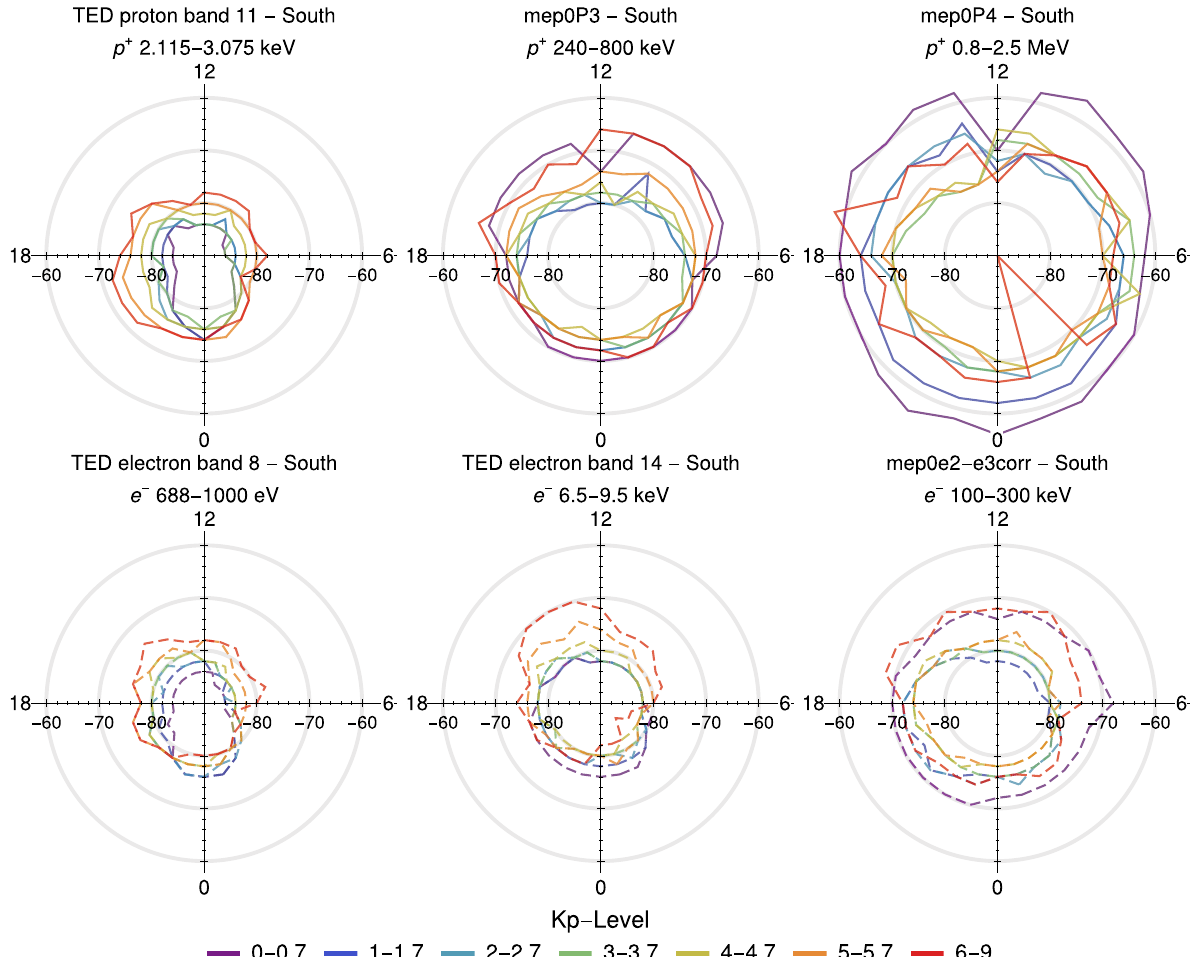
Figure 7. Position of PPFD areas for selected proton channels (top row) selected electron channels (bottom row). Data for all Kp levels are shown in MLAT-MLT coordinates, where MLAT is a modi fi ed Apex magnetic latitude and MLT is the corresponding local